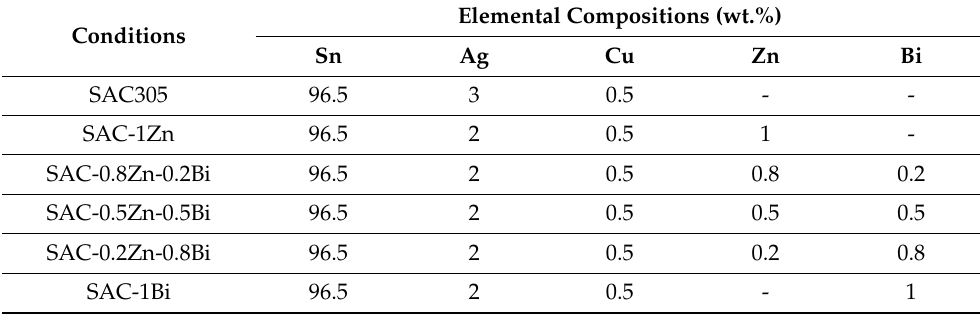
Table 1. Elemental compositions before casting